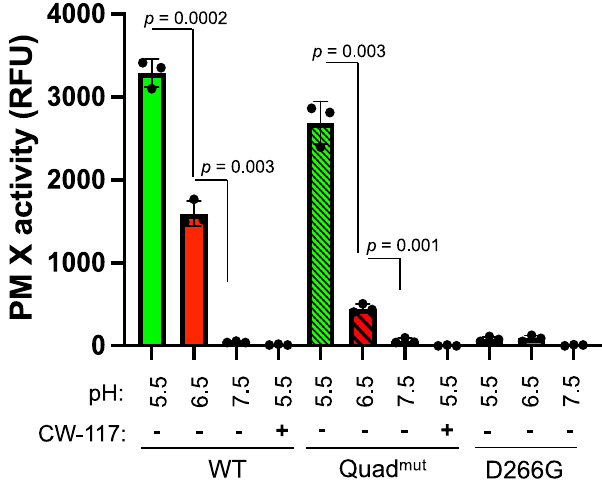
Fig. 3 | Proteolytic processing is not necessary for in vitro activity of PM X. Second copy PM X-GFP was puri fi ed from synchronized 42 – 45h schizonts using anti-GFPantibody.Thepulleddownproteinswerethenincubatedwith fl uorogenic Rh2N substrate peptide (1 μ M) at the indicated pH. In control wells, CWHM-117 (1 μ M)wasaddedtoinhibitPMXactivity.Reactionswerecarriedoutfor1hat37°C. Mean values from three independent experiments are shown and error bars represent standard deviations. Data were analyzed statistically by two-tailed Stu- dent ’ s t test, p valuesareshownonthegraph.SourcedataareprovidedasaSource Data fi le.